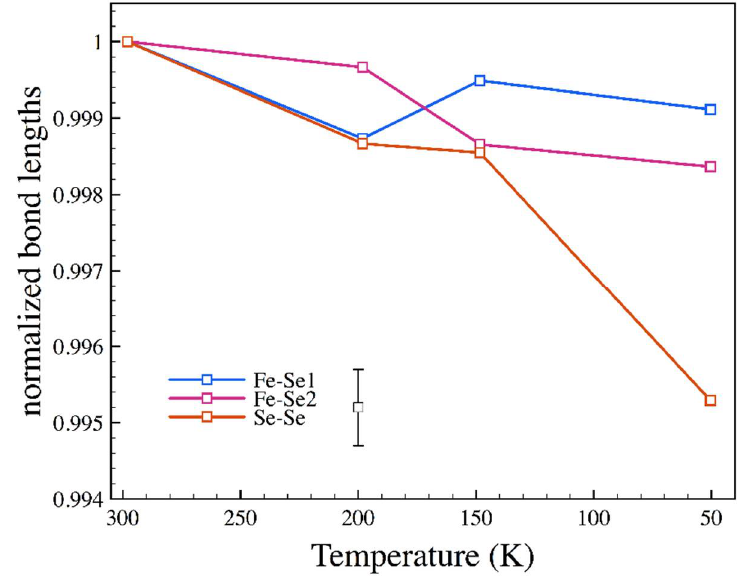
Figure 7. Variation of the unit-cell volume as a function of temperature at ambient pressure. Red, green and blue symbols show values of three different crystals whereas black symbols refer to weighted average values.